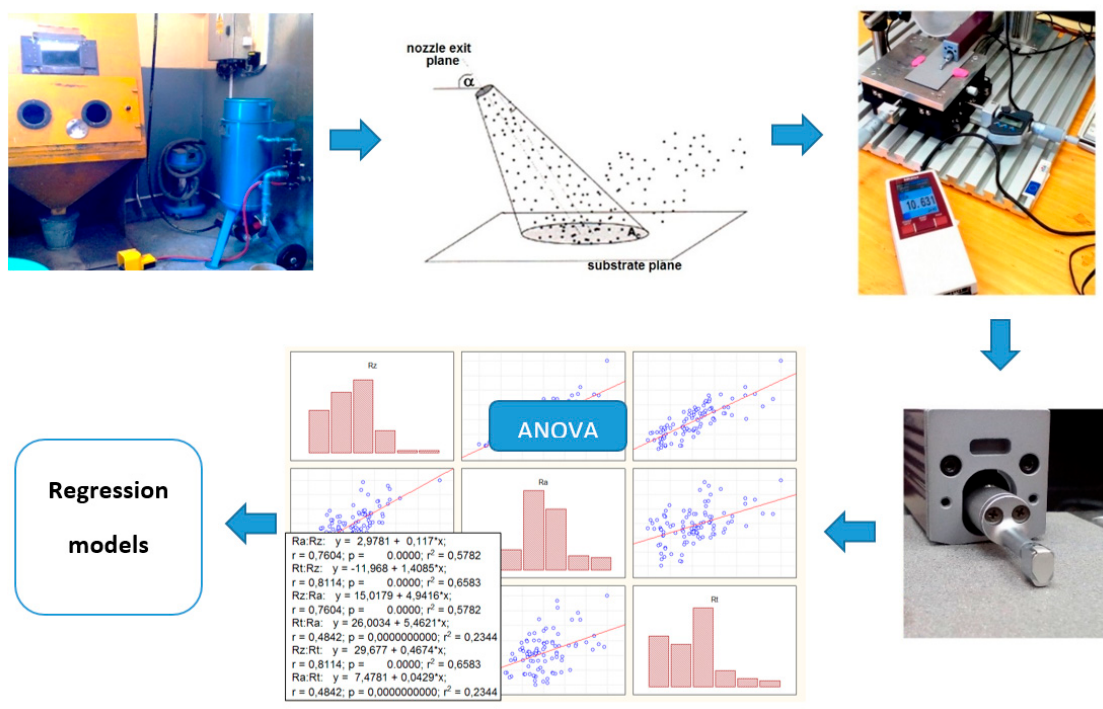
Figure 4. The principle of the experiment.